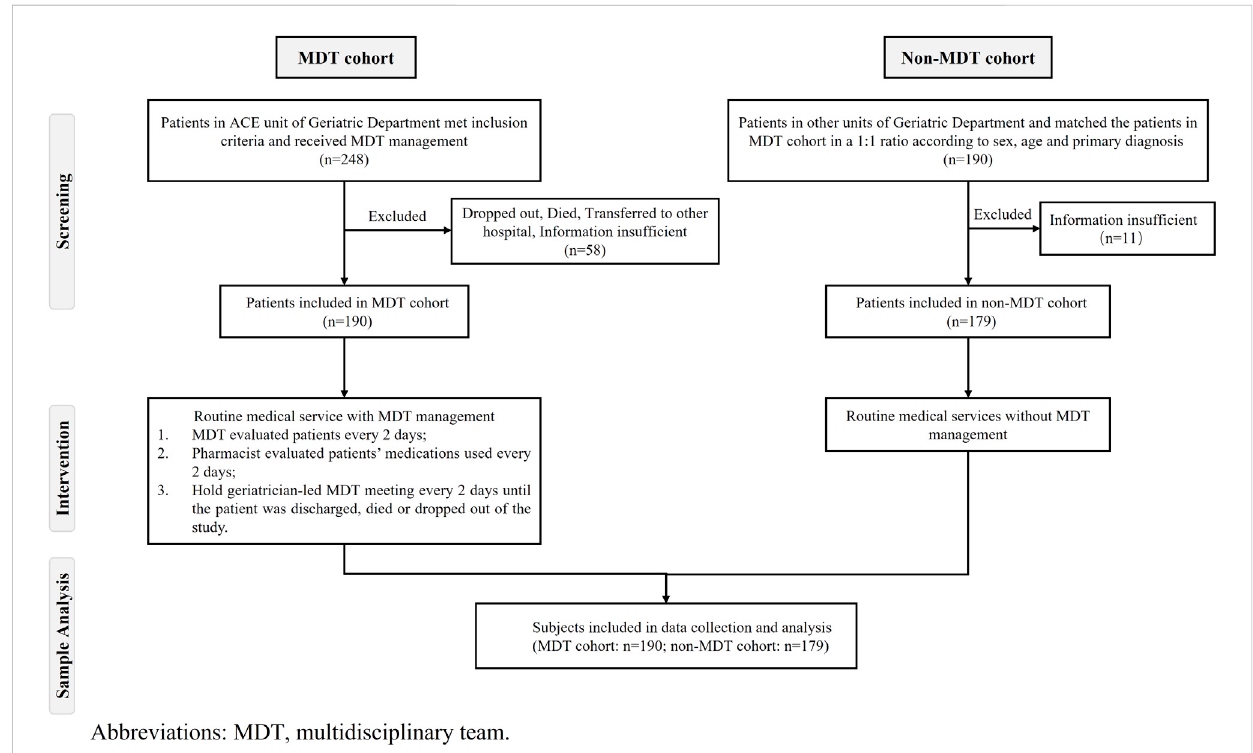
FIGURE 1 Flowchart of patient eligibility for the